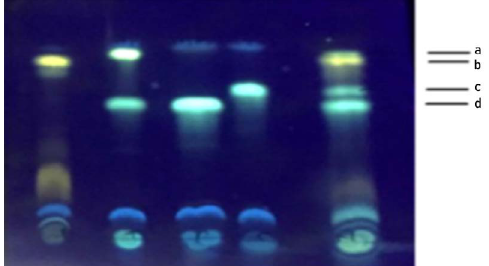
Fig. 2. TLC separation of dansylated standard amines and the amines produced by E. hormaechei on a precoated silica gel plate. Lane 1: Histamine, Lane 2: Tyramine and Putrescine, Lane 3: Putrescine, Lane 4: Cadaverine and Lane 5: Standards a: Tyramine, b: Histamine, c: Cadaverine, d: Putrescine